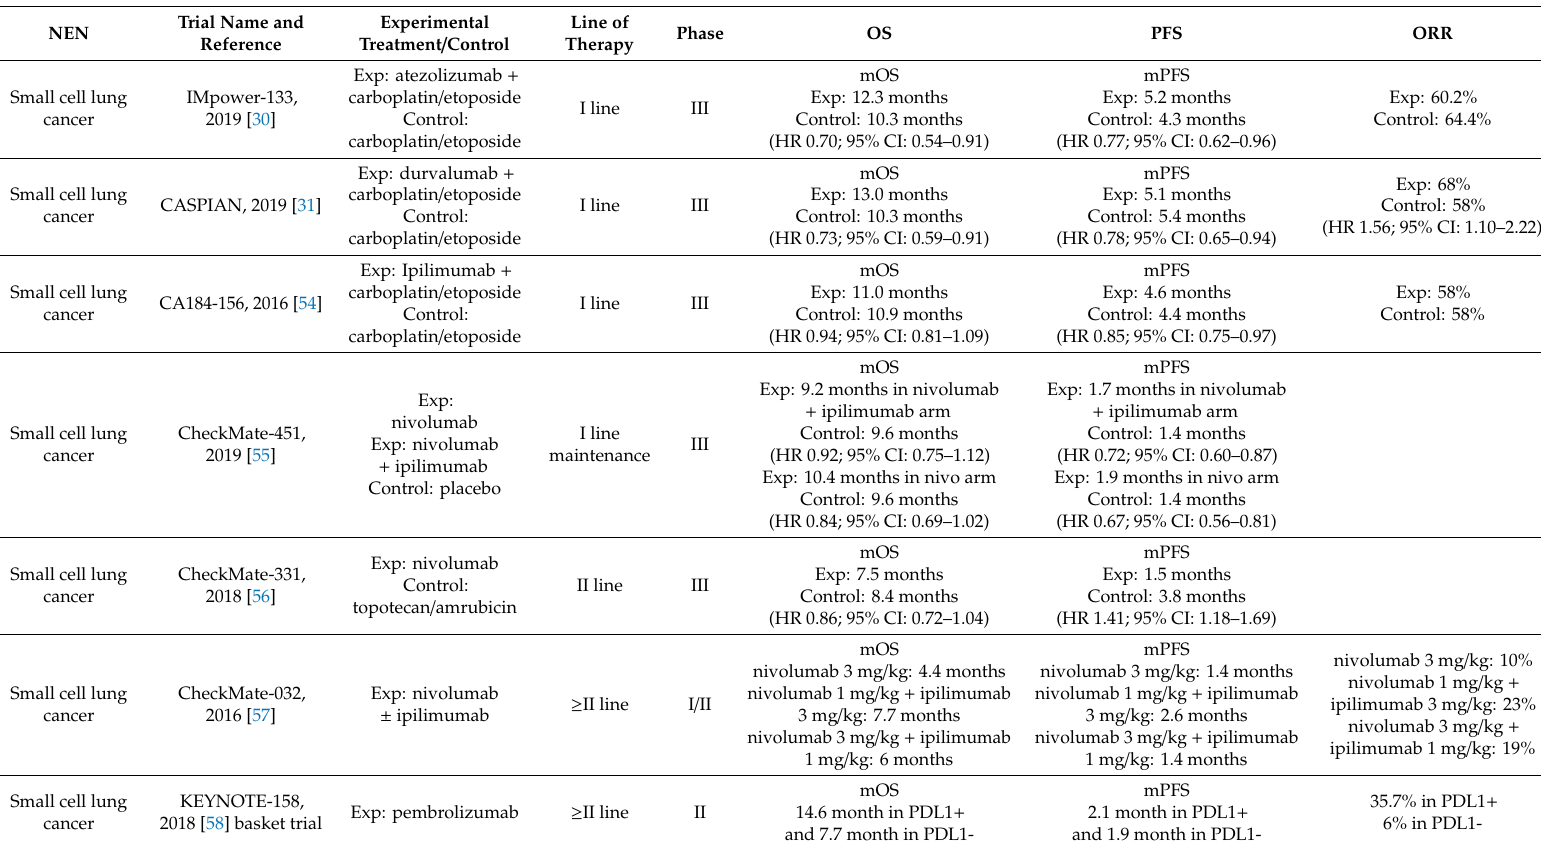
Table 1. Studies discussed in the text and their main results divided by type of NEN. Abbreviations: Exp, experimental; mOS, median overall survival; mPFS, median progression-free survival; ORR, objective response rate; NEN, neuroendocrine neoplasia; HR, hazard ratio; CI, confidence interval; PD-L1, programmed cell death ligand